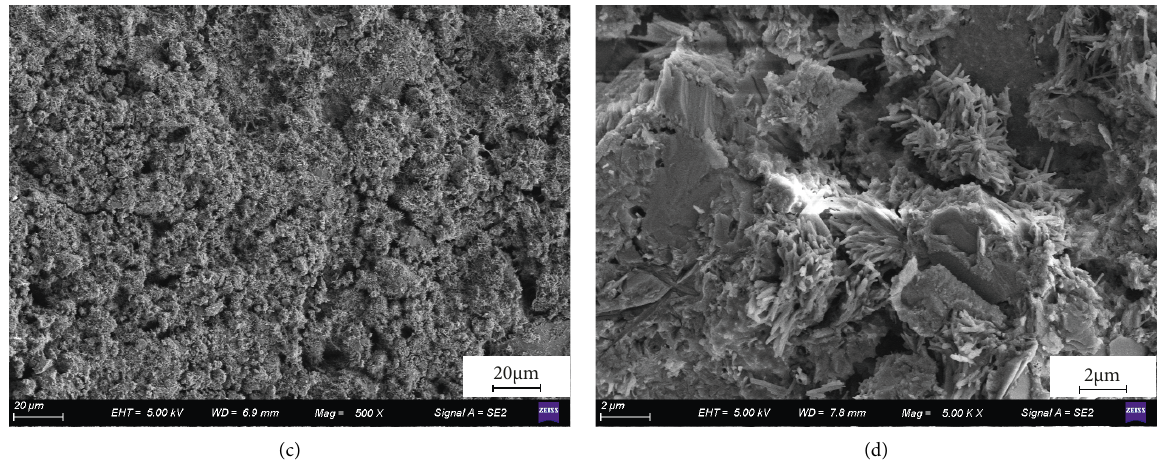
Figure 16: Microscopic damage characteristic diagram of samples (RCA replacement rate is 30%) under 200 F-T cycles: (a) RAC3-IOT0; (b) RAC3-IOT3; (c) RAC3-IOT5; (d)